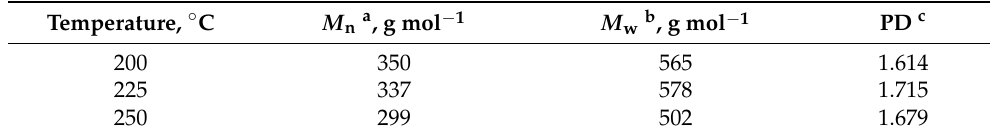
Table 6. Effect of temperature of spruce wood RCF over the 3RS450 catalyst for 3 h on the molecular weight characteristics of the liquid products.